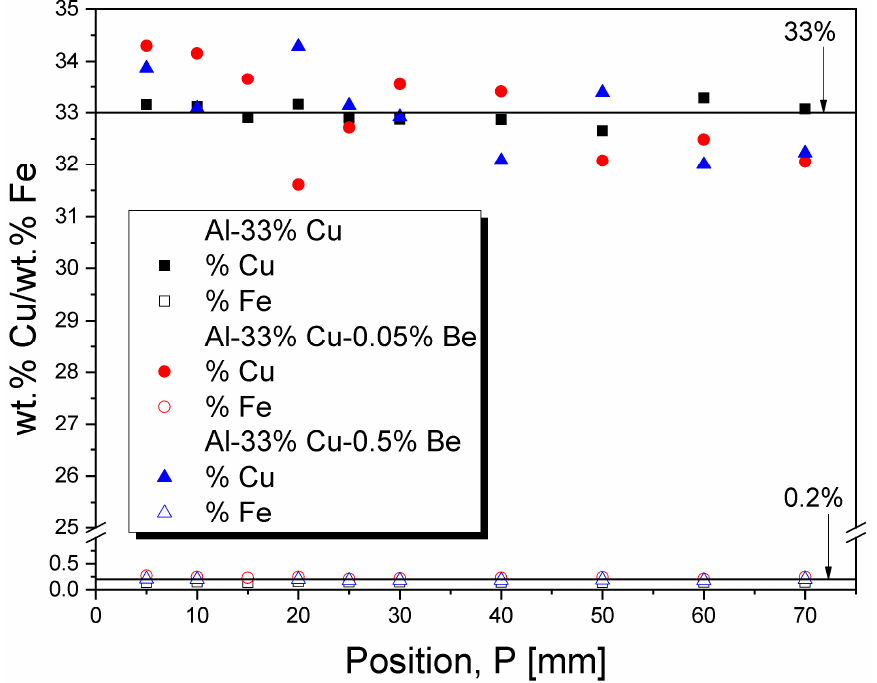
Figure 7. Cu and Fe (residual) distribution along the length of Al-33 wt.%Cu data from [19], Al-33 wt.%Cu-0.05 wt.%Be and Al-33 wt.%Cu-0.5 wt.%Be DS castings. Table 2. Beryllium content (wt.%) in Al-33 wt.%Cu-0.05 wt.%Be and Al-33 wt.%Cu-0.5 wt.%Be alloys. Alloy %Be Al-33wt.%Cu-0.05wt.%Be 0.055 ± 0.02 Al-33wt.%Cu-0.5wt.%Be 0.60 ±